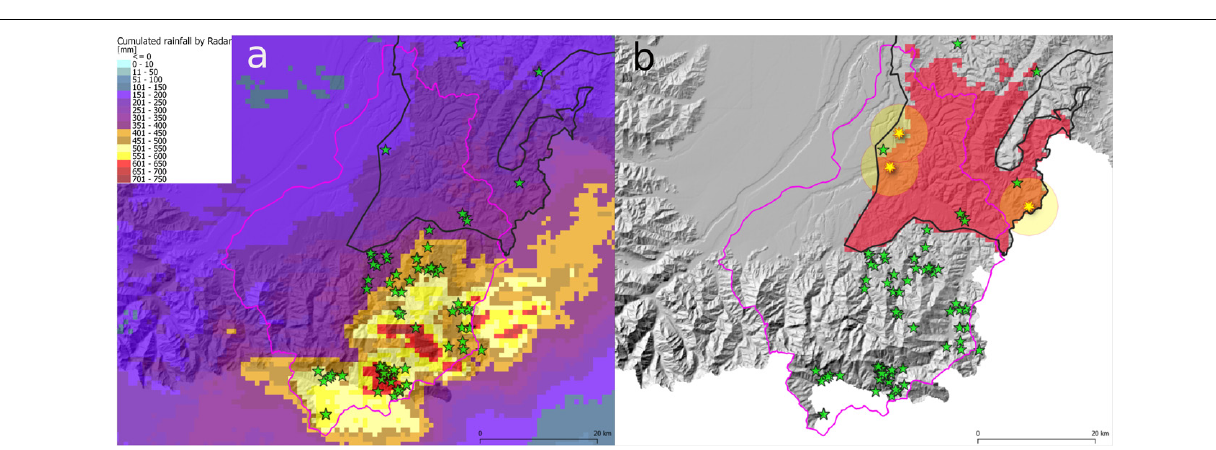
FIGURE 8 | (a) Accumulated rainfall from 25th November at 06:00 UTC over hilly areas (delimited by black contour). (b) In red, areas interested by precipitations that overpassed thresholds of Equation 4 (critical rainfall accumulations) and rain gages overpassing threshold (yellow asterisks) and related buffers (yellow circles); green star labels indicate occurred